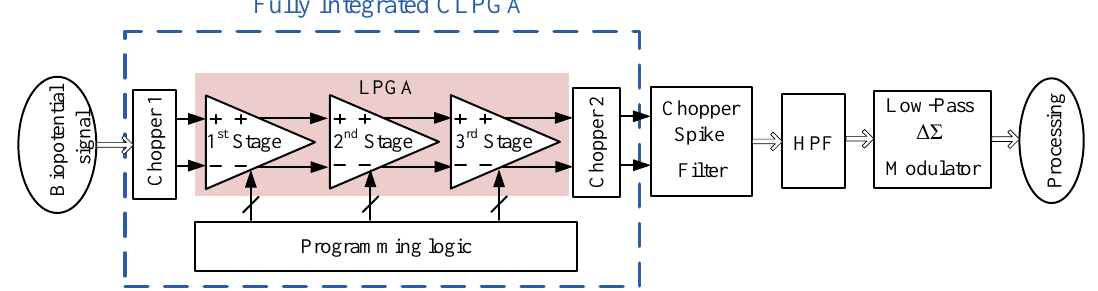
Figure 1. Block diagram of the EEG acquisition system with the proposed CLPGA.